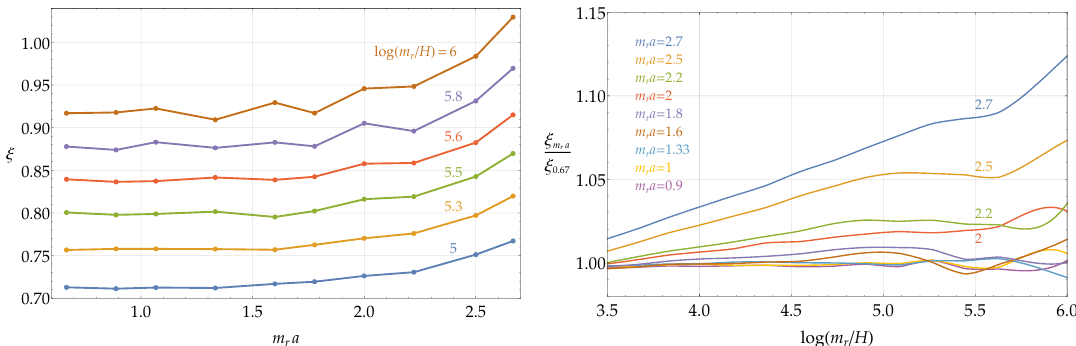
Figure 14 . Left: the continuum extrapolation of (cid:24) ( t ) in the step-size, m r a ! 0. The values obtained with m r a = 1 : 33 appear to have already converged to the continuum limit, typically with better than percent level accuracy. Right: results for (cid:24) ( t ) for di(cid:11)erent choices of the step-size m r a , normalised to the same quantities calculated with the (cid:12)nest lattice spacing m r a = 0 : 67. The other unphysical parameters are (cid:12)xed to a (cid:28) =a c = 1 = 3 and H f L f = 2.